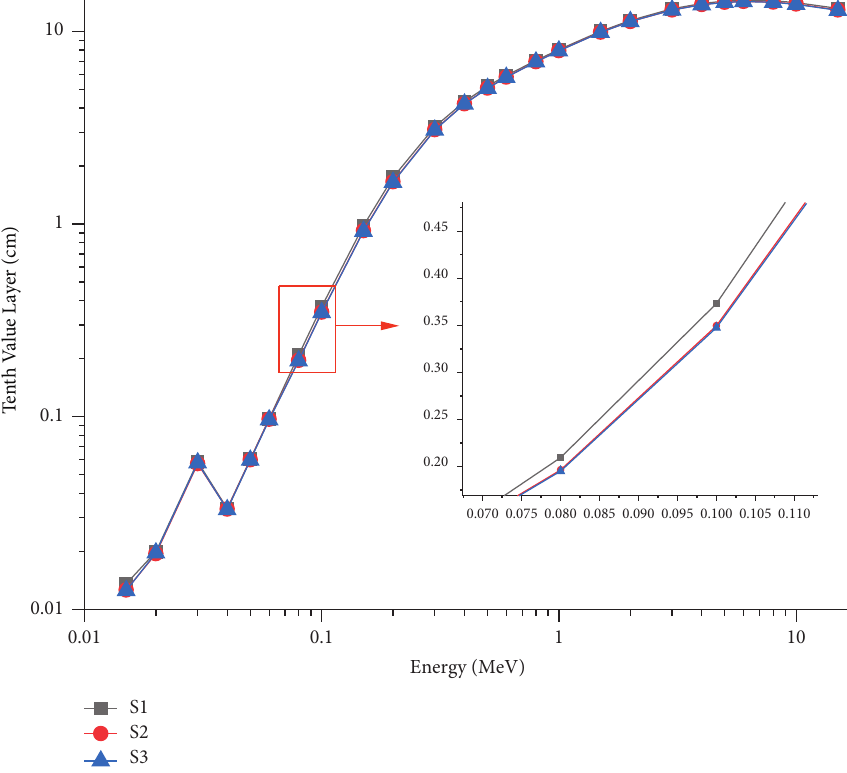
Figure 6: Variations of the tenth value layer (cm) with photon energy (MeV) for all S1–S3